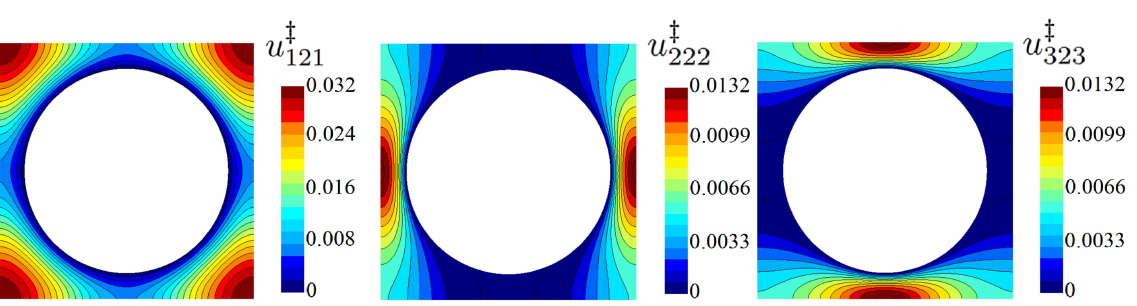
, u ‡ and u ‡ are shown for θ = 222 323 121